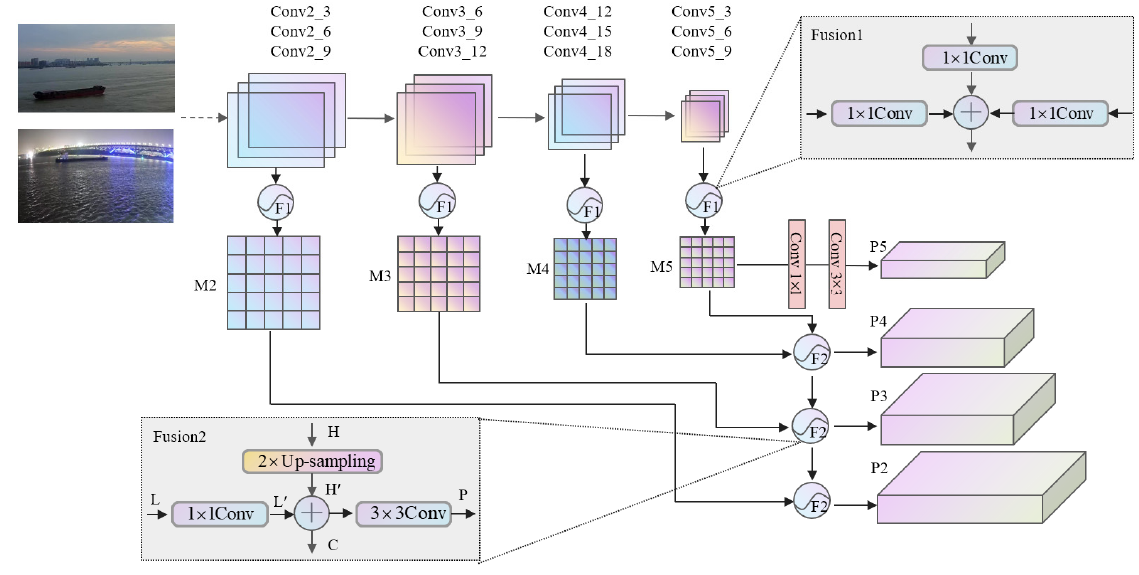
Figure 3. Improved feature fusion structure.